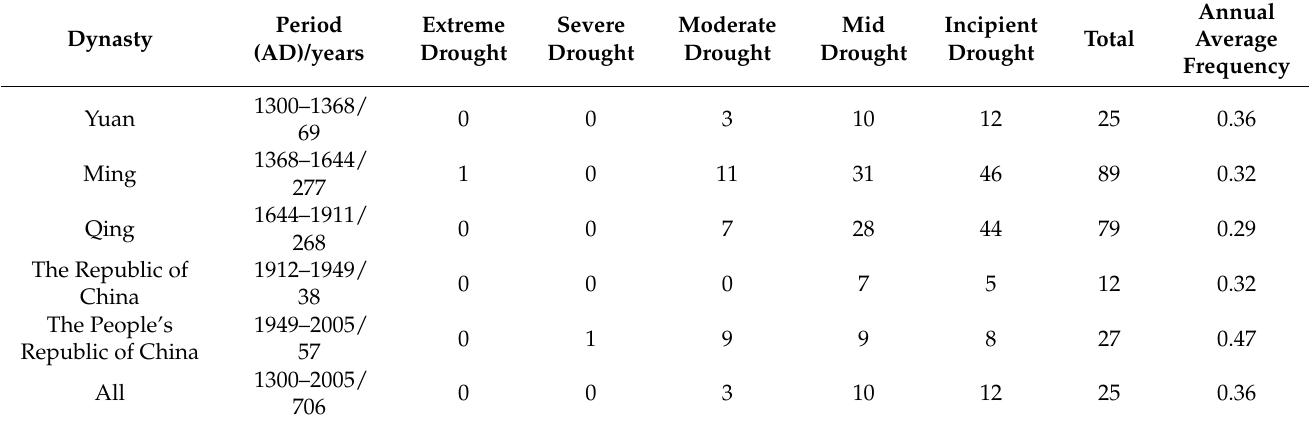
Table 2. Drought statistics of different dynasties in the study area during the AD 1300–2005